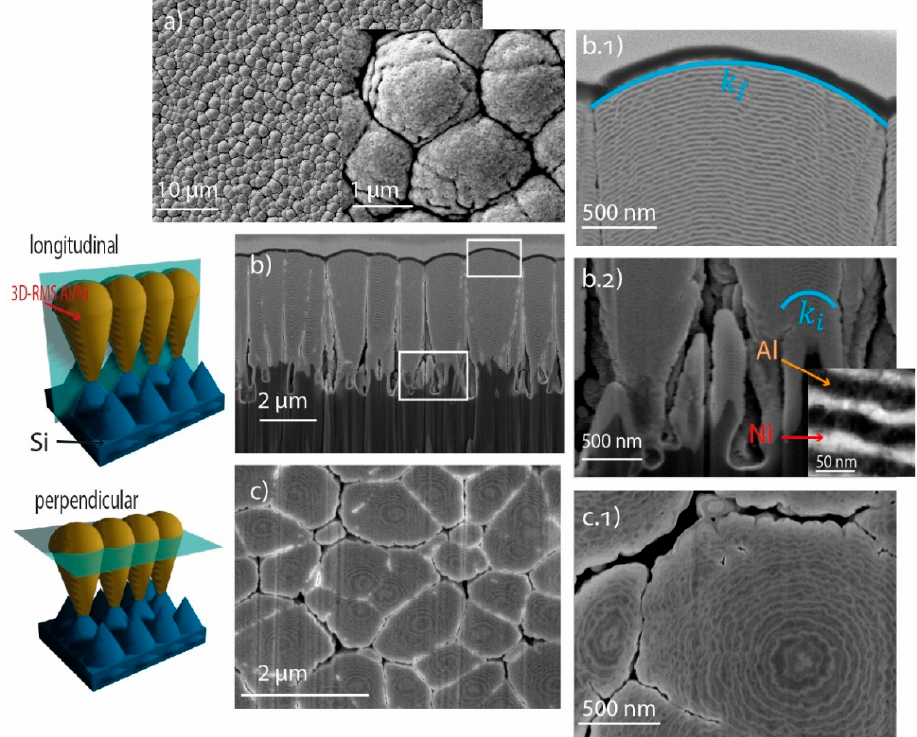
Figure 3. Scanning ( a , b , b.1 , b.2 , c , c.1 ) and transmission (inset in b.2 ) electron microscopy images of the Ni/Al multilayers